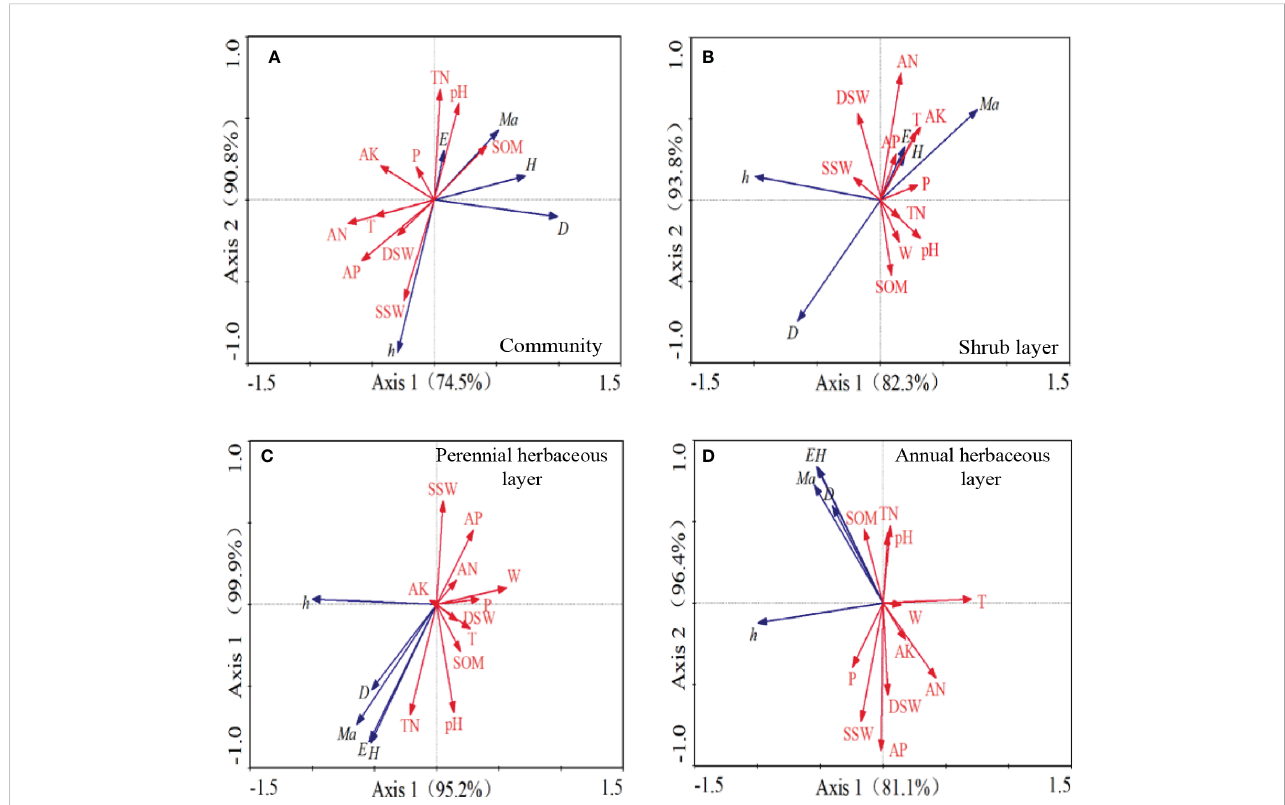
FIGURE 5 RDA constrained ordination analysis diagram of soil environmental factors, meteorological factors and plant community. AK, soil fast-acting potassium; AN, soil fast-acting nitrogen; AP, soil effective phosphorus; SOM, soil organic matter; DSW, deep Soil water content; SSW, shallow soil water content; pH, pH; D, density; h, height; H, Shannon-Wiener index; E, Pielou index; Ma, Margalef index; T, average growing season temperature; W, maximum growing season wind speed; P, growing season